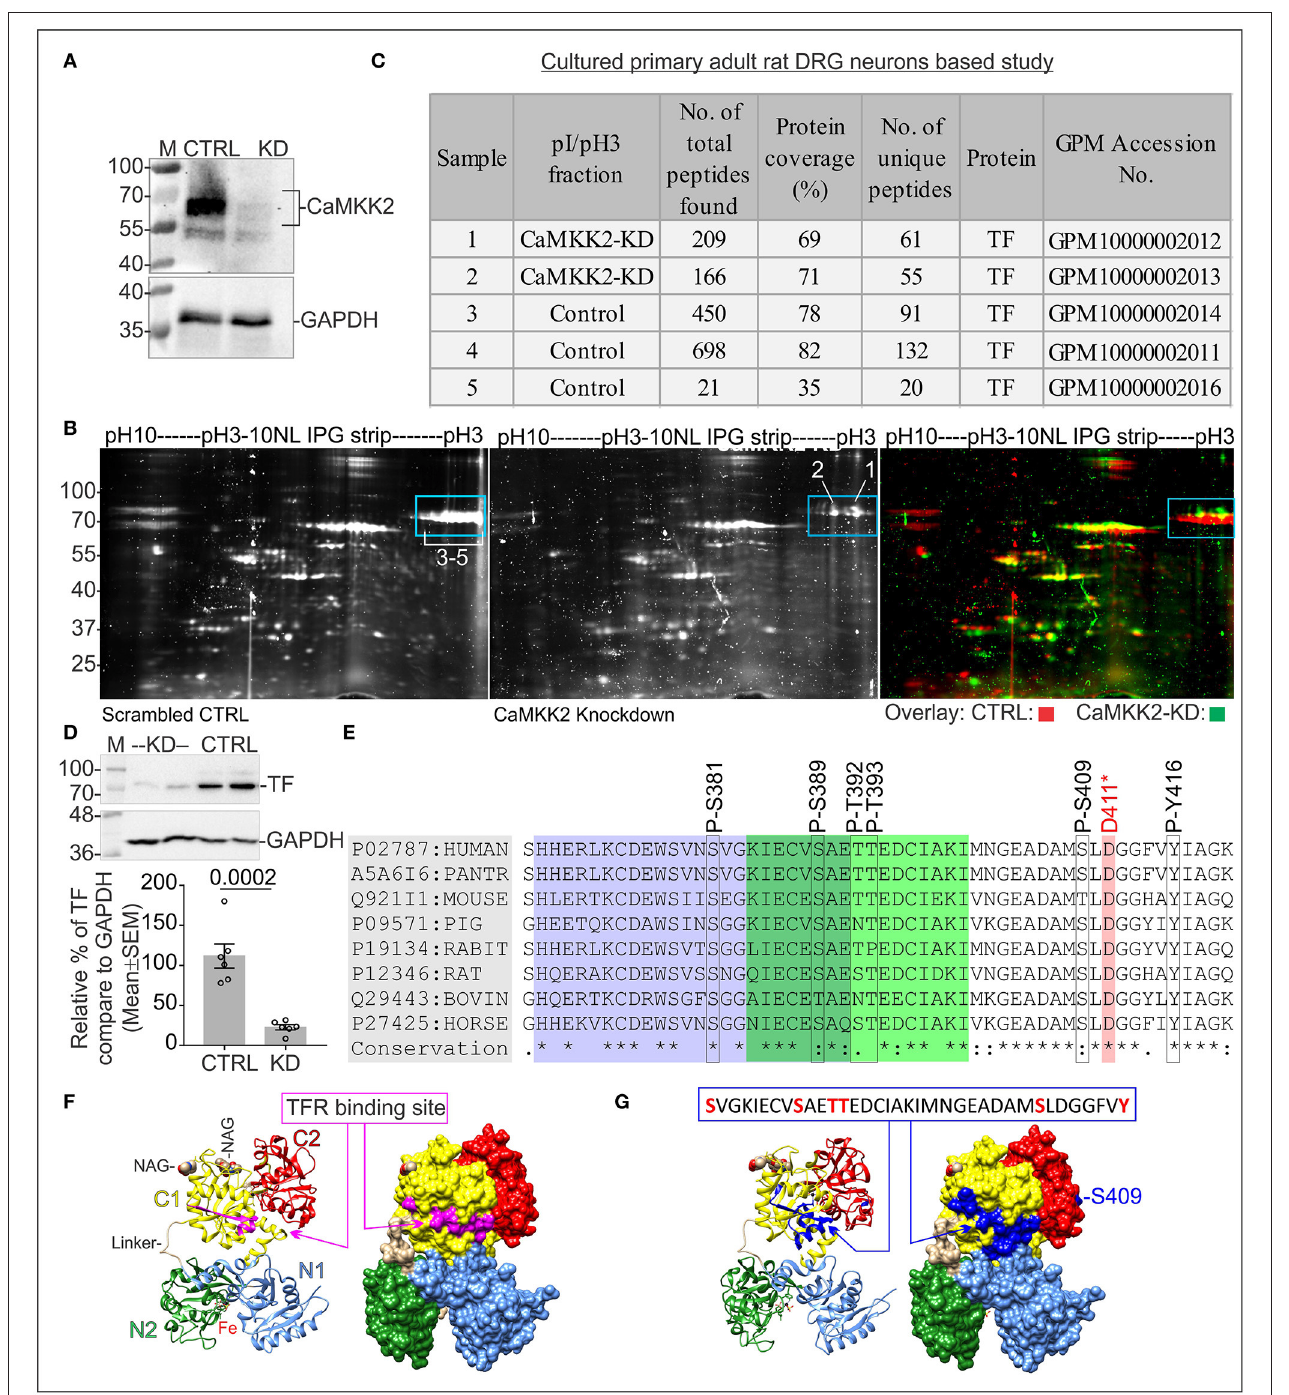
FIGURE 1 | Protein profiling in CaMKK2 KD cultured adult primary rat DRG neurons. (A) Immunoblots showing expression of CaMKK2 and GAPDH. CTRL, scrambled control, KD, knockdown. The LNP based delivery of siRNAs knocked down 98% of CaMKK2 in DRG neurons. The protein lysates were obtained from DRG neurons cultured for 48h following transfection. (B) Oriole stained IEF/SDS-PAGE gel showing focused proteins. Blue rectangle areas show the difference in the focused protein fractions. The gel images (CTRL and KD) were false-colored and overlaid in the right panel to highlight the differences. Arabic numerals indicate gel spots that were used for in-gel trypsin digestion and mass spectrometric identification of the proteins. The numbers are equivalent to the sample numbers in (C) . (C) Table summarizes mass spectrometry findings. Data is accessible at Global Proteome Machine (https://thegpm.org) website using the GPM identifiers. (D) Immunoblots showing expression of TF and GAPDH. CTRL, scrambled control; KD, knockdown. The protein lysates were obtained from DRG neurons cultured for